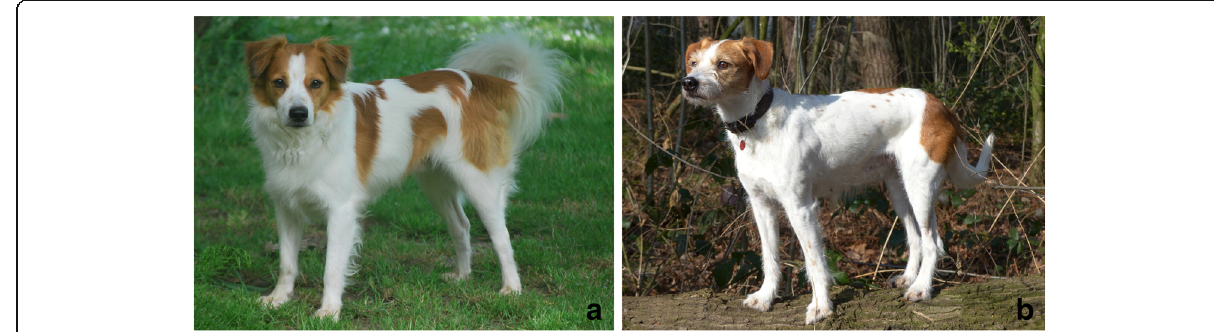
Fig. 1 Purebred Kromfohrländer. Kromfohrländer come in two different coat types, smooth haired, with a smooth face, no beard and long soft hair, while the wirehaired Kromfohrländer have a beard. A smooth haired Kromfohrländer is shown in a and a wirehaired representative in